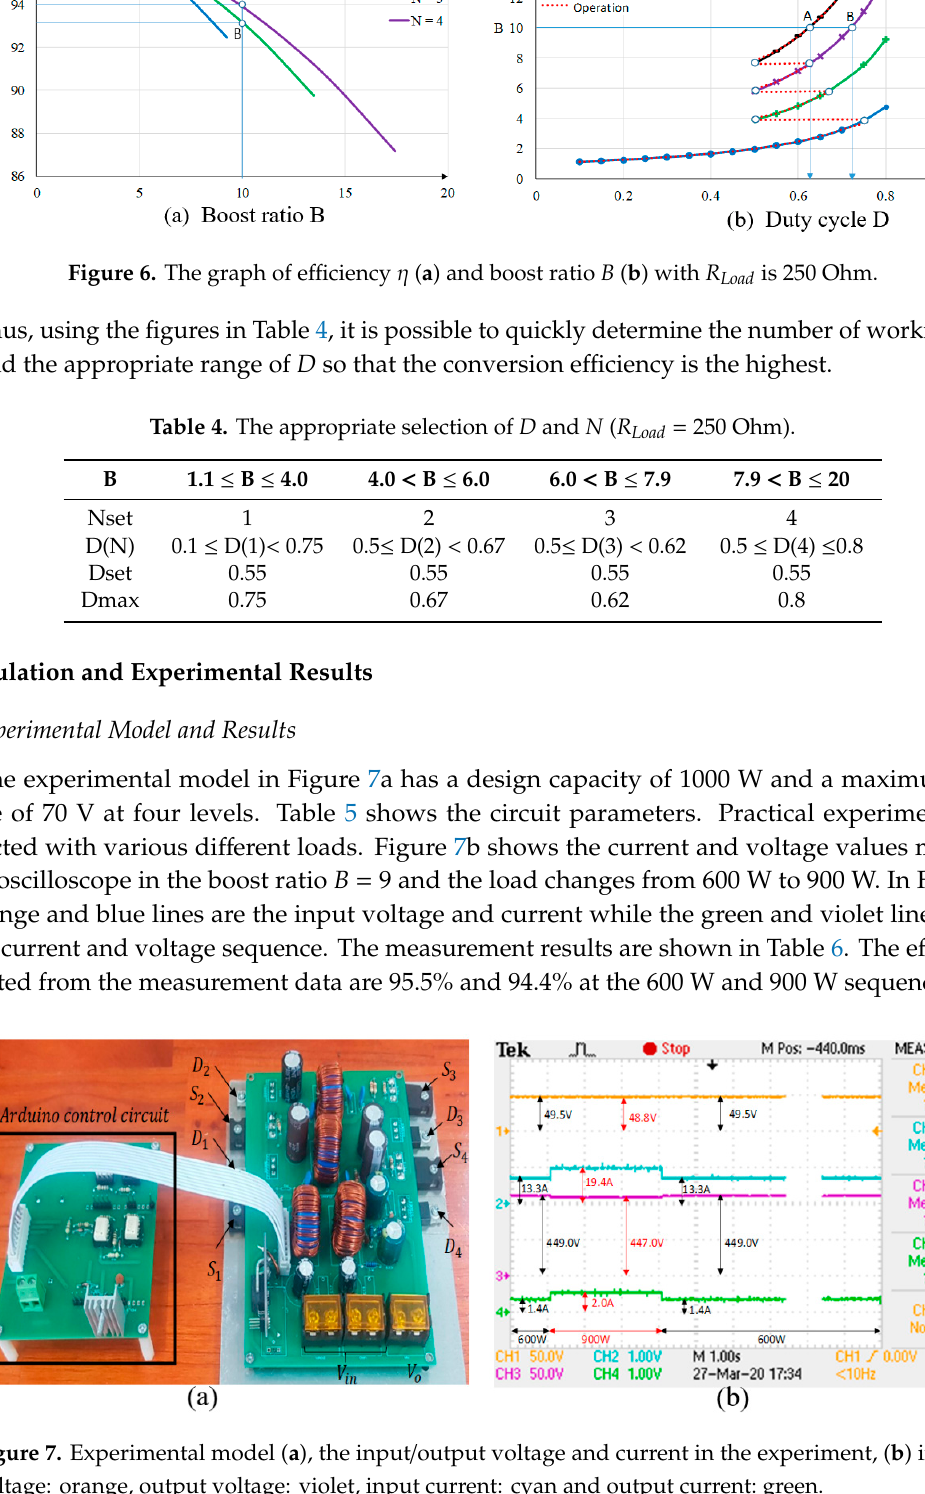
Figure 5. Plotting flowchart of η and B form N and D .